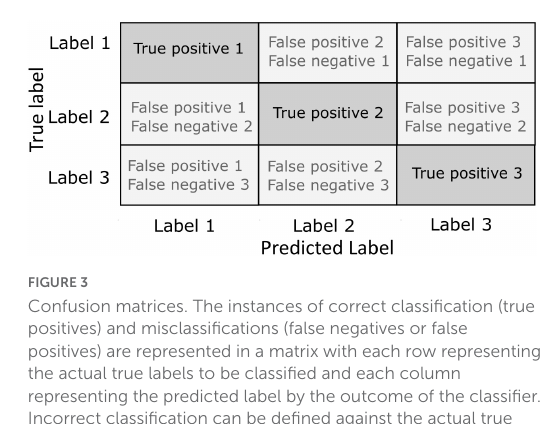
FIGURE3 Confusion matrices. The instances of correct classification (true positives) and misclassifications (false negatives or false positives) are represented in a matrix with each row representing the actual true labels to be classified and each column representing the predicted label by the outcome of the classifier. Incorrect classification can be defined against the actual true label as a false negative or against the predicted label as a false